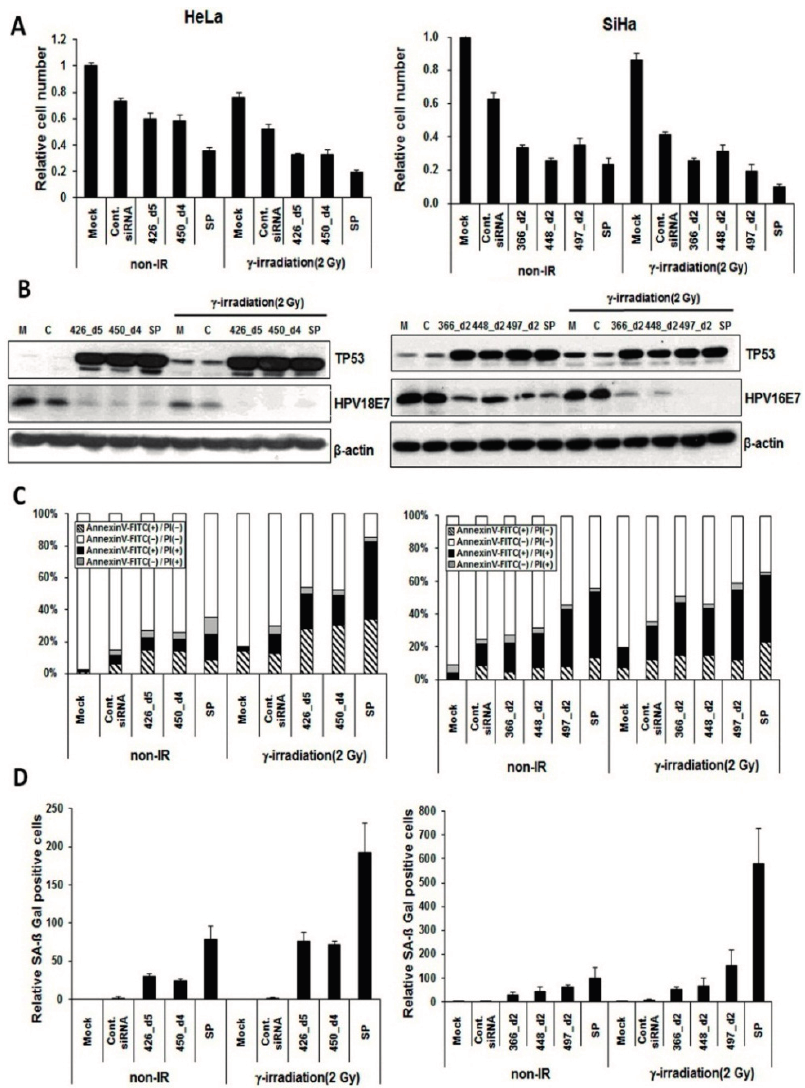
Figure 4. Synergistic effect of E6/E7-specific siRNA pools in combination with radiation on cervical cancer cells. HeLa cells were transfected with 20 nM of each selected siRNA derivative or siRNA pools (SP; 10 nM siRNA each) or in combination with γ -irradiation. Similarly, SiHa cells were transfected with 20 nM of each selected siRNA derivative or SP (7 nM siRNA each) or in combination with γ -irradiation. The number of cancer cells was determined by siRNAs alone (non-IR) or siRNAs in combination with γ -irradiation. Untransfected and control siRNA served as controls. ( A ) Trypan blue assay showing the number of viable cells transfected with siRNA pools, siRNA alone and in combination with γ -irradiation; ( B ) Western blotting analyses showing the expression of TP53 and HPV E7 proteins. M, mock; C, control siRNA; SP, siRNA pool; ( C ) Annexin-V and PI binding assay showing the percentages of apoptotic cells transfected with selected siRNA derivatives; and ( D ) The effect of HPV E6/E7-specific siRNAs on cellular senescence is also